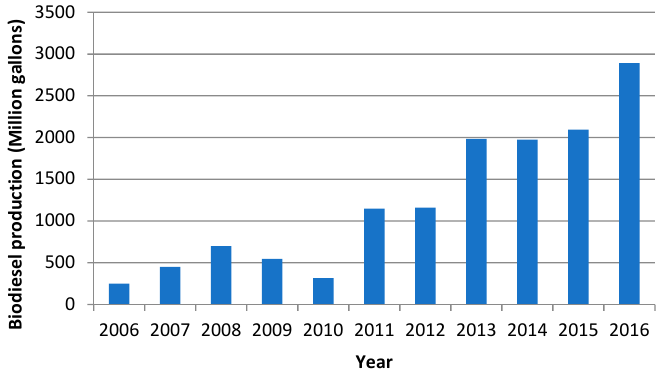
Figure 2. United States biodiesel growth pattern for the period 2006 to 2016 [19].